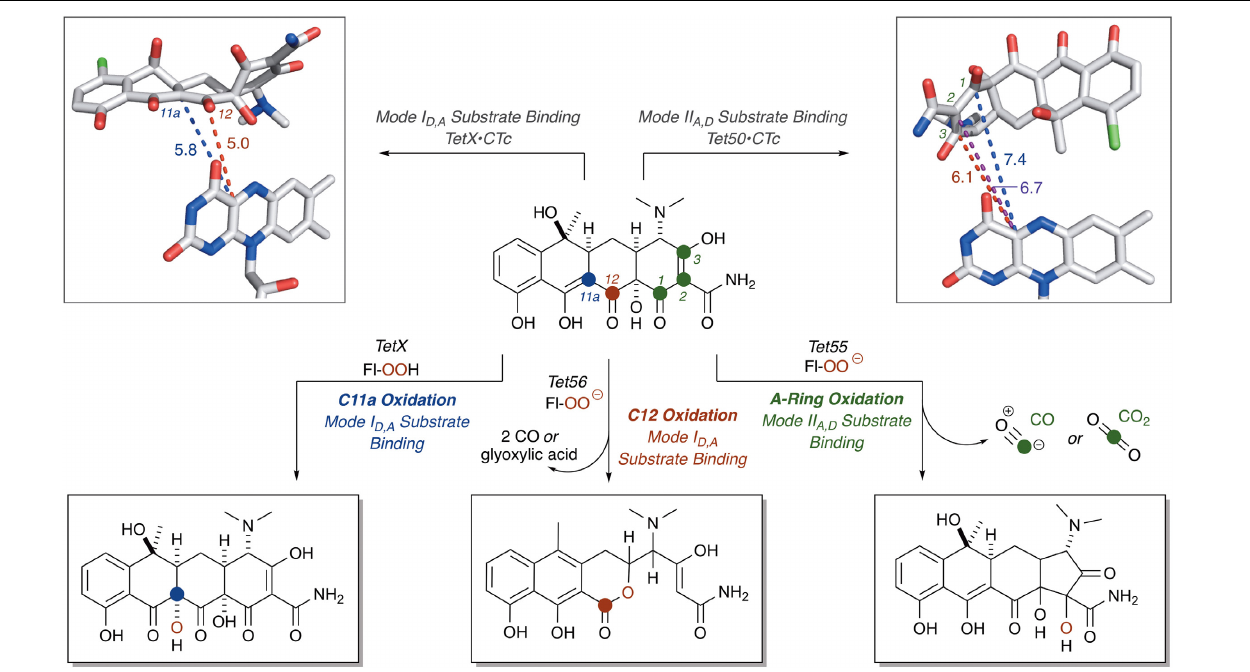
FIGURE 7 | Victim of fate: the site of tetracycline oxidation is determined by binding mode and distance from flavin-C4a. Bond distances to reactive centers on CTc bound to TetX in Mode I D , A (PDB ID: 2y6r) and CTc bound to Tet50 in Mode II A , D (PDB ID: 5tui) were determined in PyMOL from the corresponding PDB files. Images of FAD were generated using PyMOL